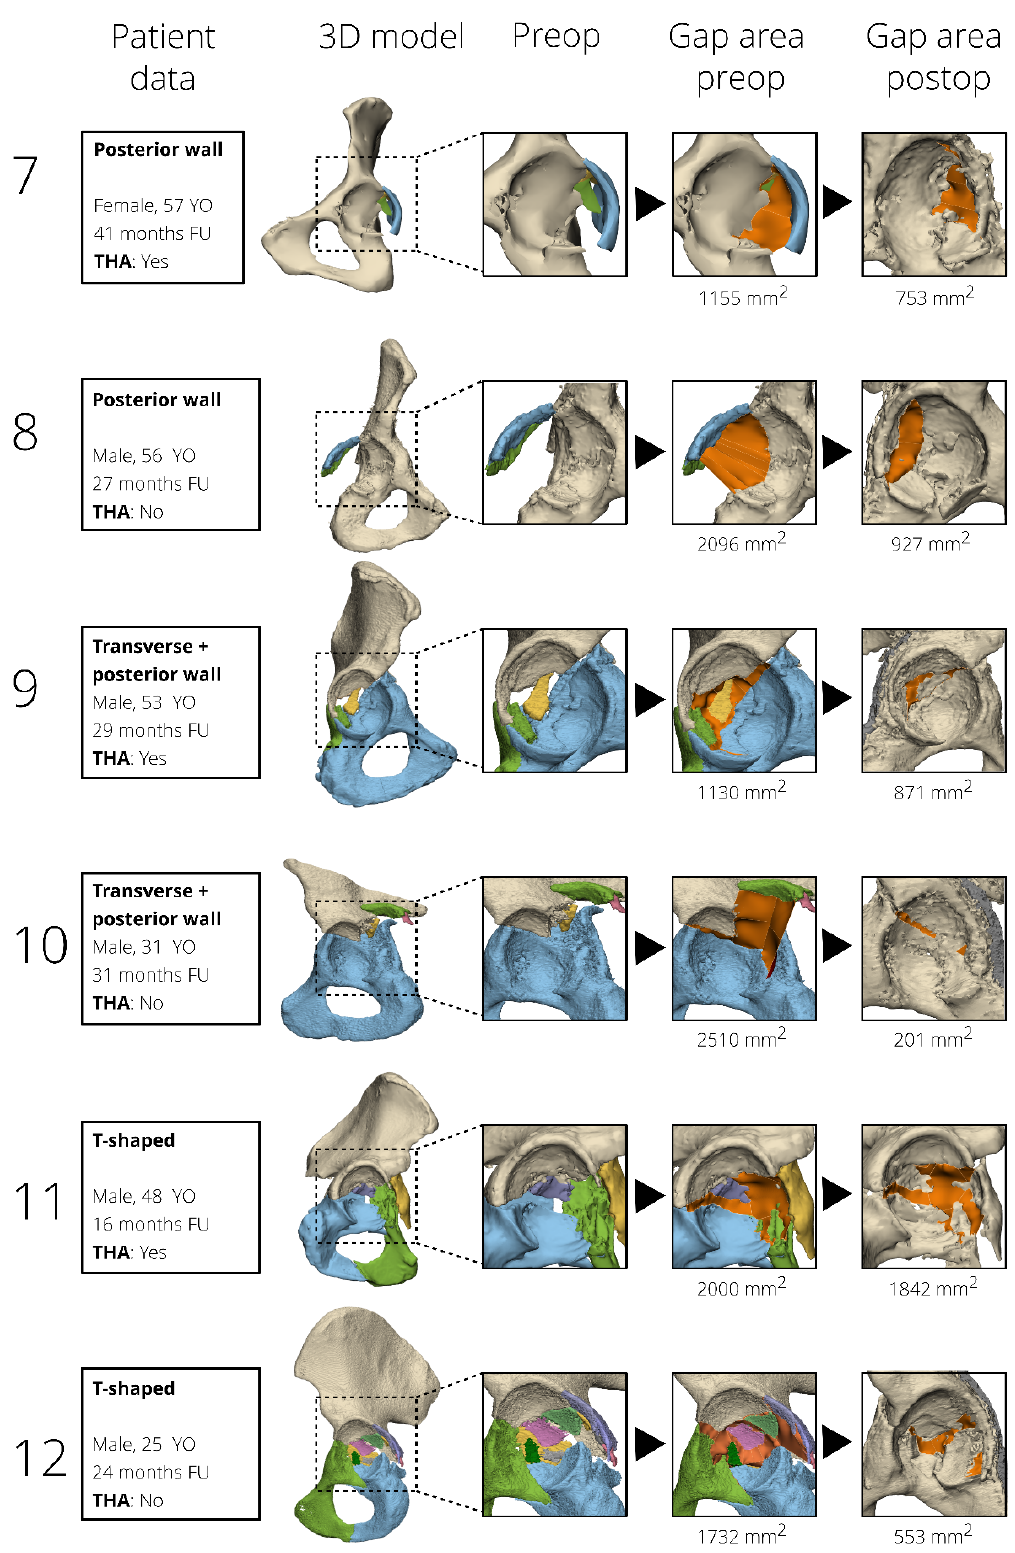
Figure 4. Case examples of 12 patients, surgically treated for different types of acetabular fractures, are presented in order to correlate fracture displacement (as measured by the 3D gap area, orange) to clinical outcome. The pre- and postoperative 3D gap area are indicated in orange. The cases are sorted based on fracture type. YO: years old, FU: follow-up, THA: total hip arthroplasty.